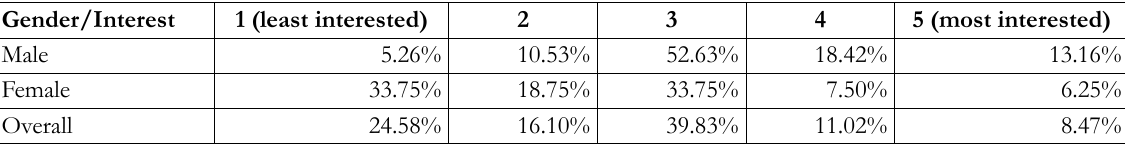
Table 1. Initial Interests in